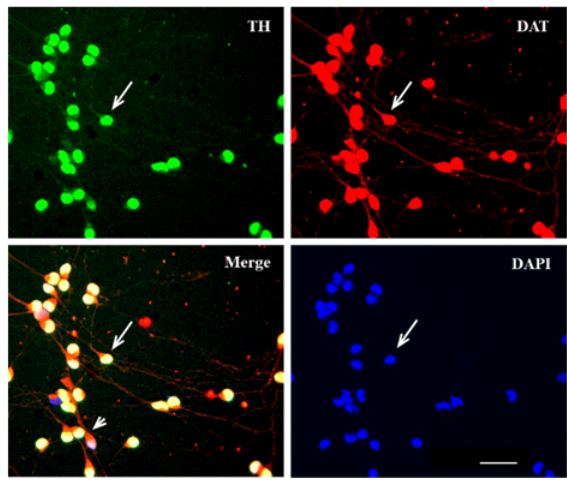
Figure 4. LUHMES cells double-immunostained for tyrosine hydroxylase (TH, green. AlexaFluor 488) and dopamine transporter (DAT, red, AlexaFluor546), with nuclei stained with DAPI (blue). Merge-colocalization of TH, DAT and DAPI (yellow) Arrows indicate cells immunostained for TH and DAT and stained with DAPI; the arrowhead indicates the transition zone of the cell body to the cell process, occupied by DAT. Objective magnification = × 20 (Plan-Neufluar). Bar = 50 µ m.